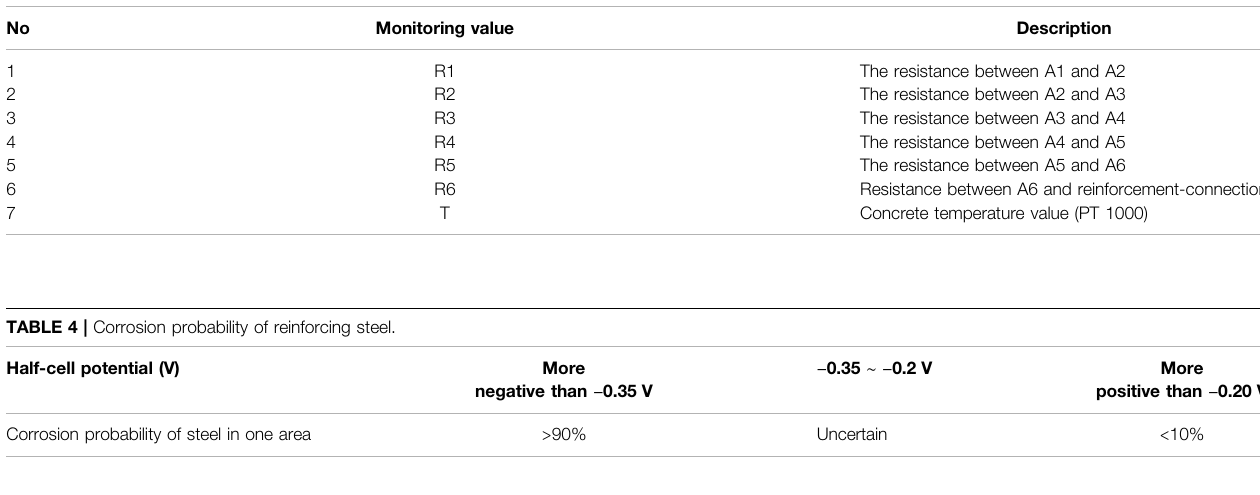
TABLE 3 | Resistance values collected by the anode-ladder sensor.